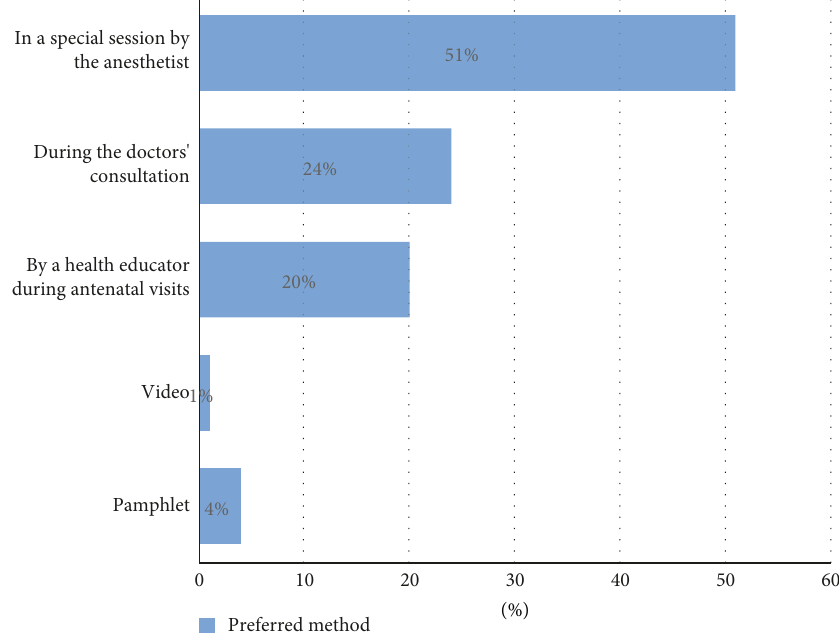
Figure 1: Preferred method for